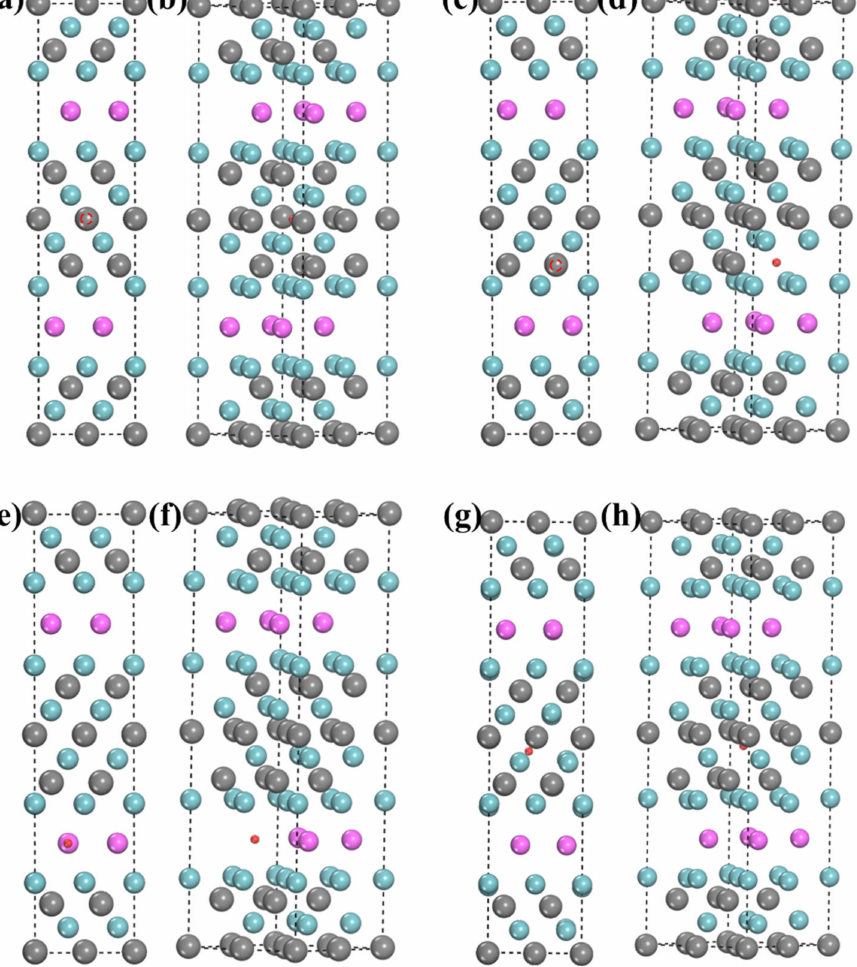
Figure 5. Lowest-energy structures for H incorporation into different vacancies of Nb 4 AlC 3 ( a , b ) C(1)v; ( c , d ) C(2)v; ( e , f ) Alv;( g , h )